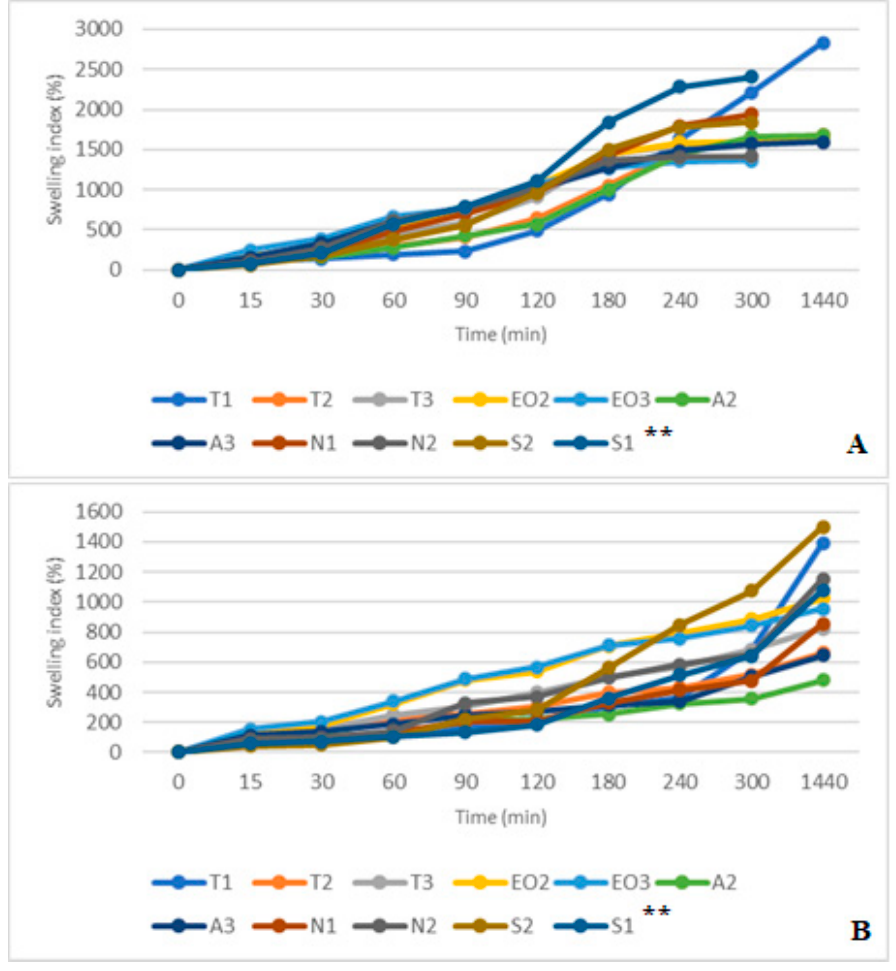
Figure 12. ( A ) NEO-loaded calcium alginate microcapsules swelling in simulated intestinal juice (SIF) media. ( B ) NEO-loaded calcium alginate microcapsules swelling in SIF + pancreatin media. ** The code is given in Table 1, n = 3.